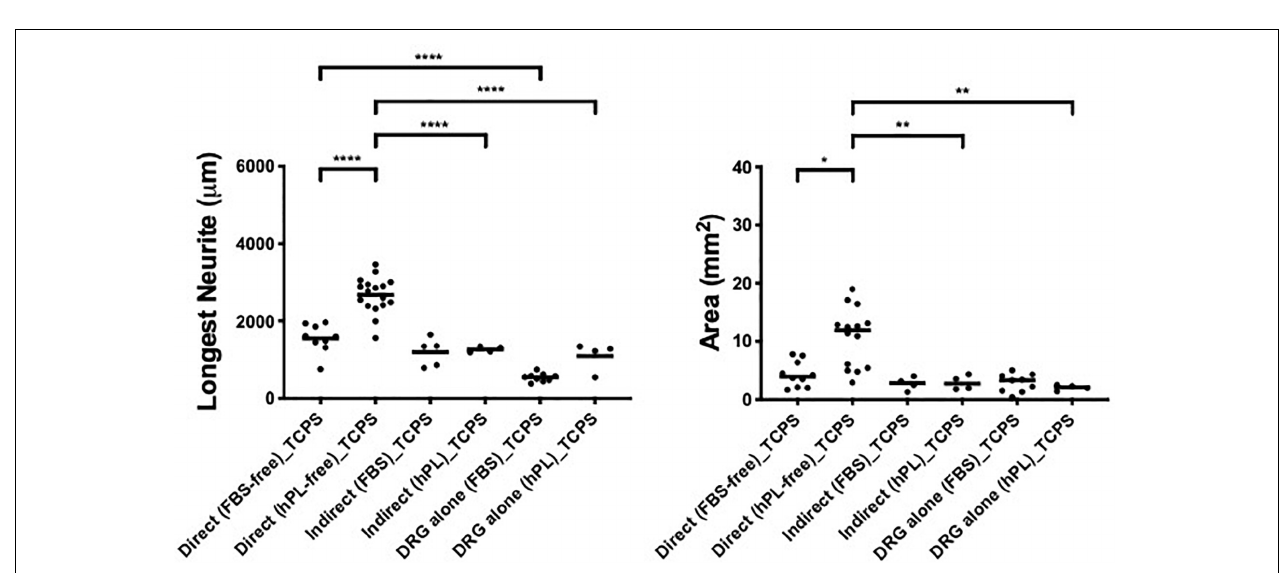
FIGURE 6 | Influence of fibronectin on DRG outgrowth. Longest neurite and axonal area of direct co-culture, indirect co-culture, and DRG alone on fibronectin (FN). Three biological repeats and at least three technical replicates (DRG) were assessed. One-way ANOVA with Tukey’s multiple comparison tests was used for assessing statistical significance among the examined groups (* p < 0.05, ** p < 0.01, *** p < 0.001, **** p < 0.0001). The number of DRG tested corresponds to the number of dots for each condition in the graph.